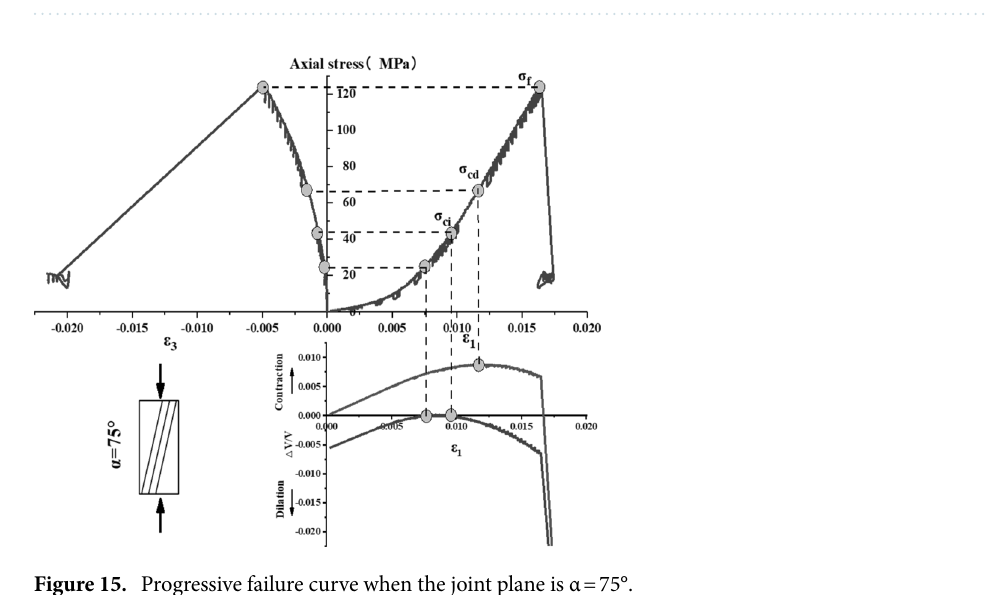
Figure 14. Progressive failure curve when the joint plane is α = 60°.